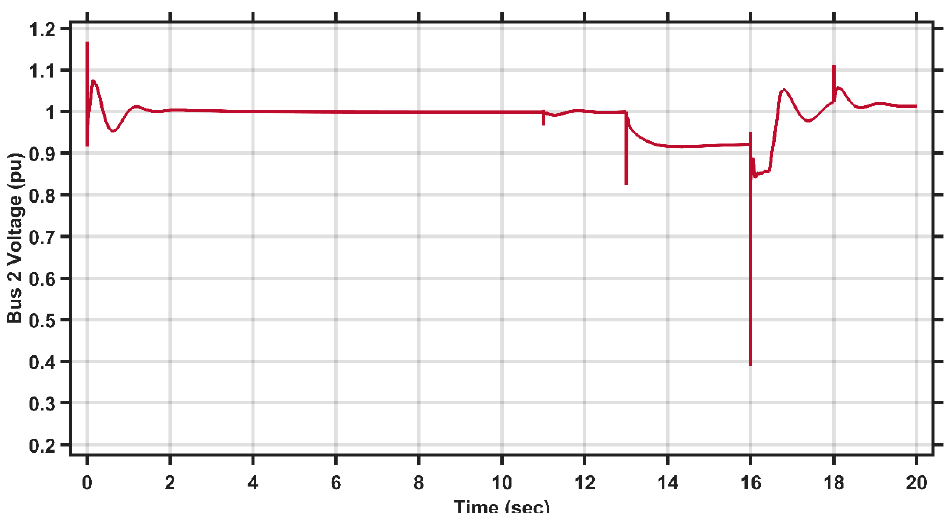
Figure 26. Bus 2 voltage at islanded operation for the IEEE 9-bus system.